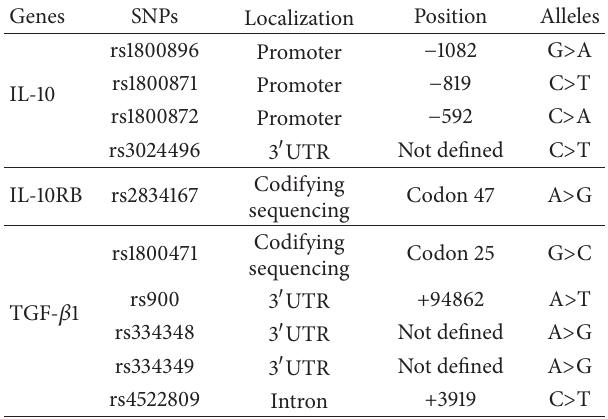
Table 2: Genes, SNPs (accession number), substitutions, localiza- tion, and position investigated in the study.